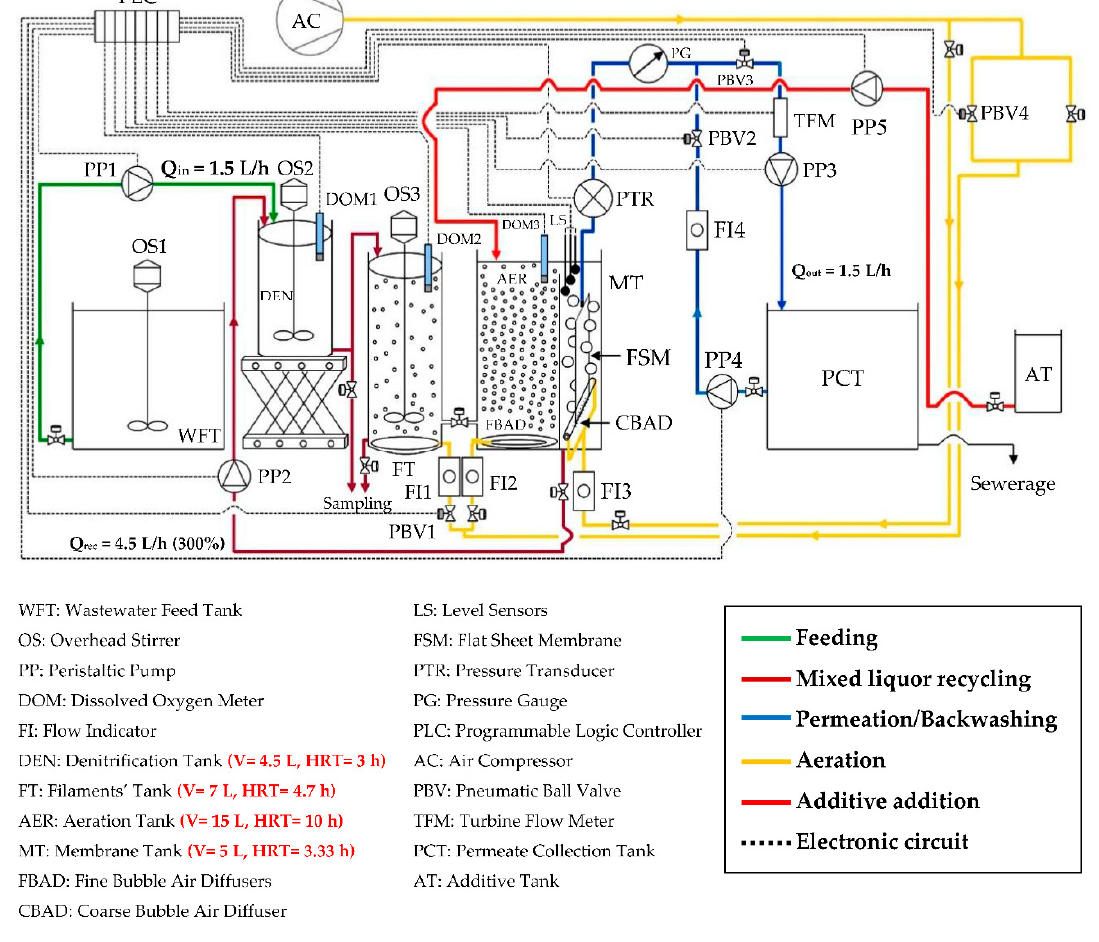
Figure 1. Schematic of pilot-scale MBR setup.